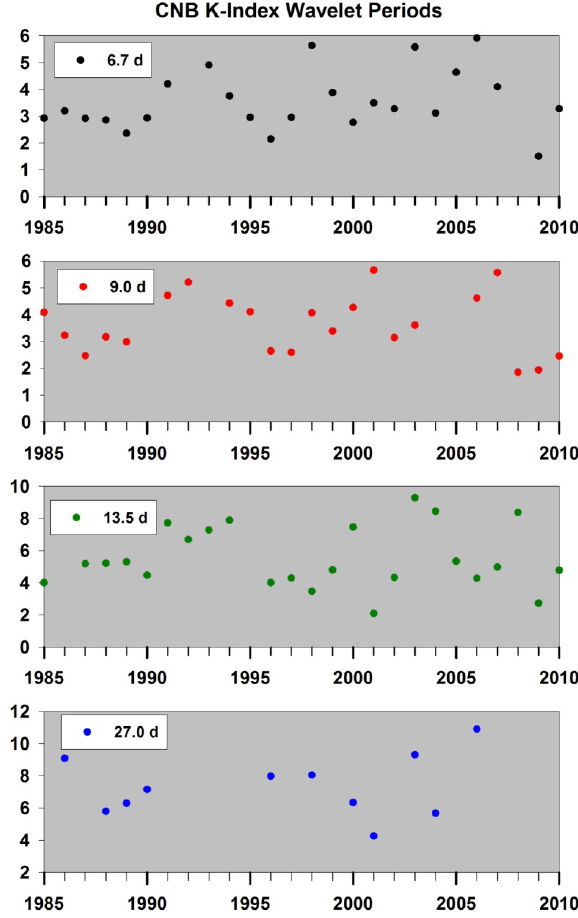
Figure 4. Periods identified in the annual time series of K indices as recorded at CNB between 1985 and 2010 using a Morlet wavelet